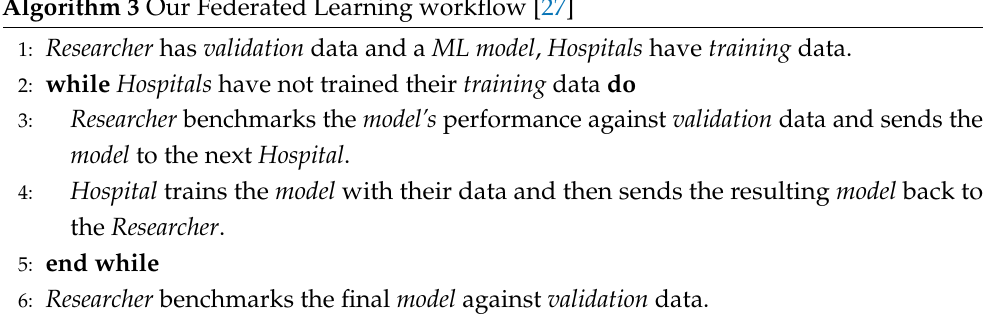
Algorithm 3 Our Federated Learning workflow